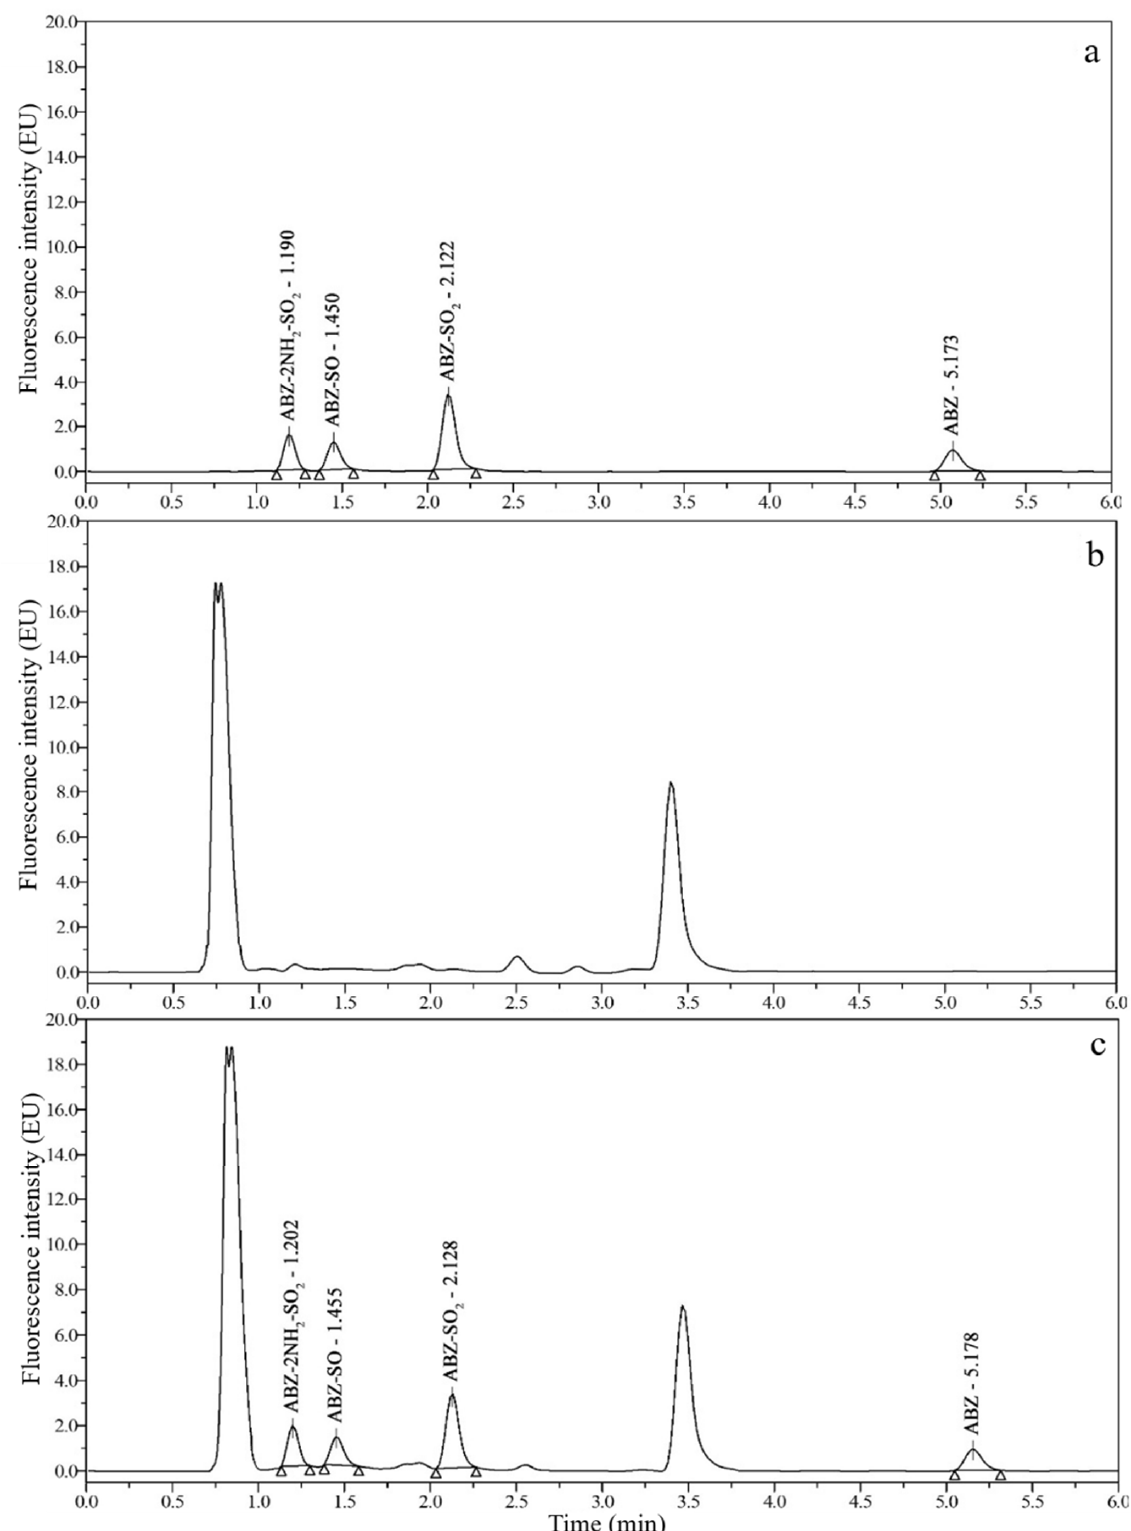
Figure 5. Chromatograms of 10 µ g/kg ABZ-2NH 2 -SO 2 , 50 µ g/kg ABZ-SO, 10 µ g/kg ABZ-SO 2 and 50 µ g/kg ABZ standards ( a ); blank goose muscle ( b ); and blank goose muscle spiked with 10 µ g/kg ABZ-2NH 2 -SO 2 , 50 µ g/kg ABZ-SO, 10 µ g/kg ABZ-SO 2 and 50 µ g/kg ABZ standards ( c ).